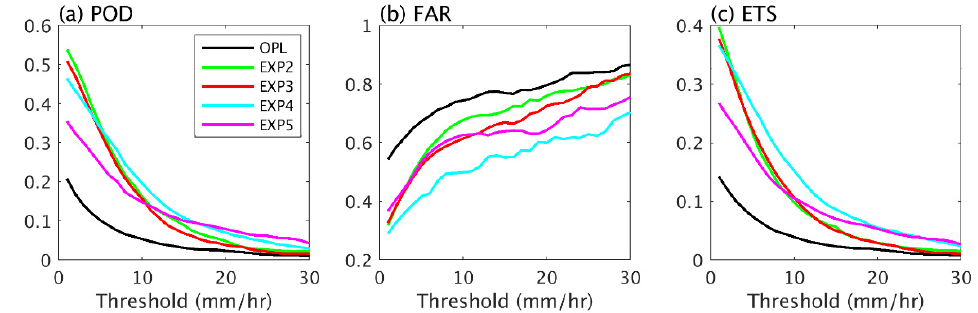
8 of 12 Figure 5. Boxplots of statistical metrics of hourly precipitation estimates estimated from each assimilation experiment and the OPL experiment. The threshold for calculating the POD, FAR, and ETS is 0.001 mm/hr, which is the threshold of distinguishing precipitation or no precipitation in the IMERG data. EXP2 and EXP3 represent experiments with nontransformed and logarithmically transformed precipitation with constant observation error, respectively; EXP4 and EXP5 are as for EXP2 and EXP3, but with increasing observation error with precipitation magnitude. A constant error in the logarithmic space ( 𝛔′ (cid:3036) = 0.3 ) corresponds to a linearly increasing error in the regular space (Equation (6)). On one hand, the linearly increasing error modifies the threshold of rejecting observations (Equations (3) and (8)), using more observations (especially heavy